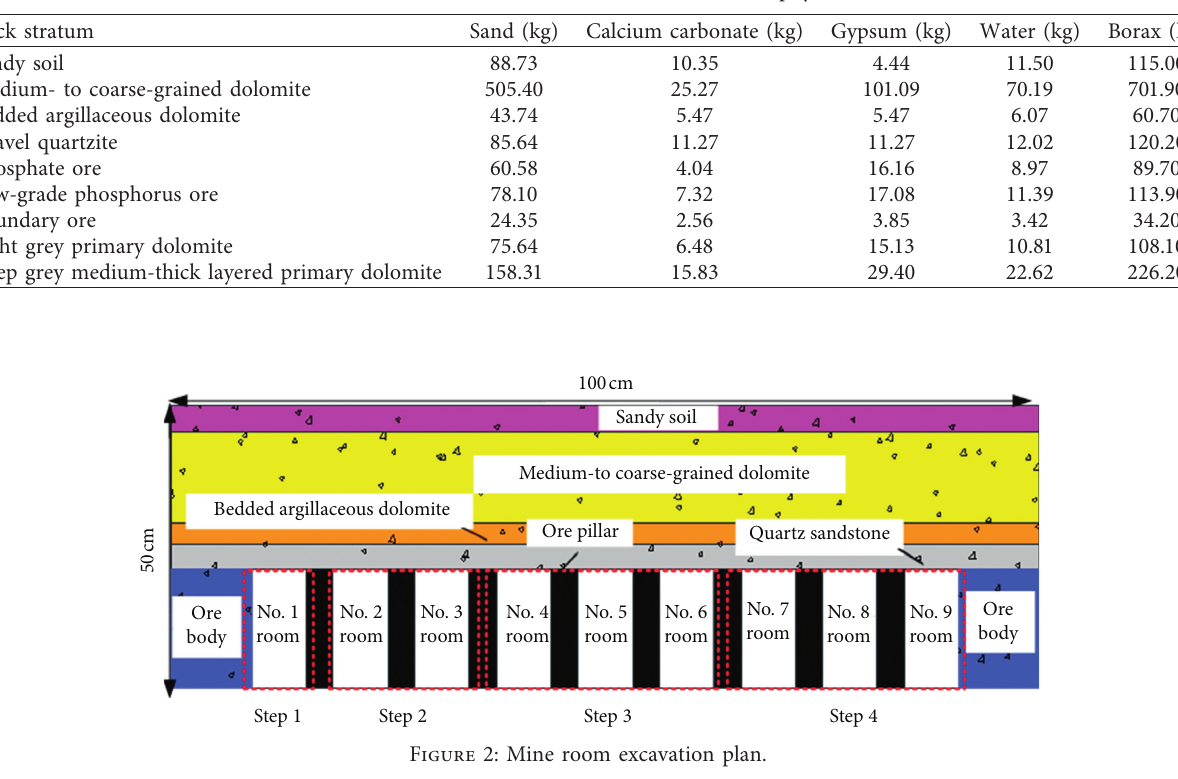
Table 2: Materials used in the rock strata of the similar physical model.